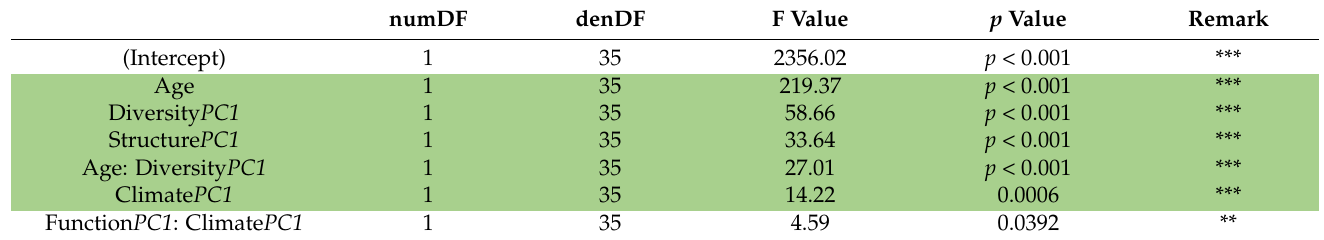
Table 3. Summary of the linear mixed-effect model of the effects of age, diversity PC1 , structure PC1 , function PC1, and climate PC1 on aboveground wood carbon, which were analyzed at for coniferous– broadleaf mixed forests (CBMF). PC1 refers to the first principal component of the results of principal component analysis. The colons represent interactions between the components. Only significant com- ponents ( p < 0.05) are reported, and the green areas are the highly significant influence components. numDF denDF F Value p